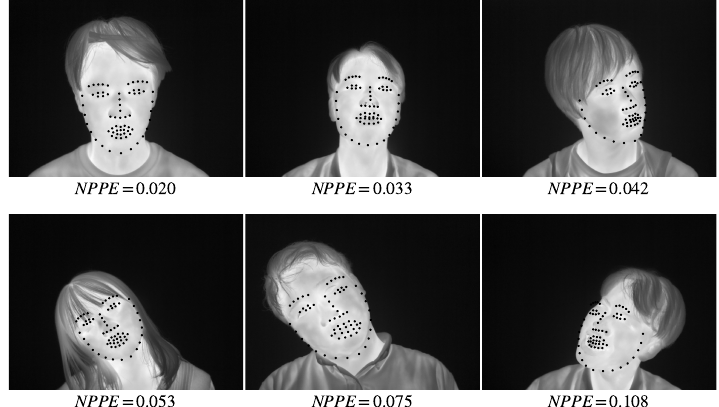
Figure 6. Examples of NPPE for each face alignment.